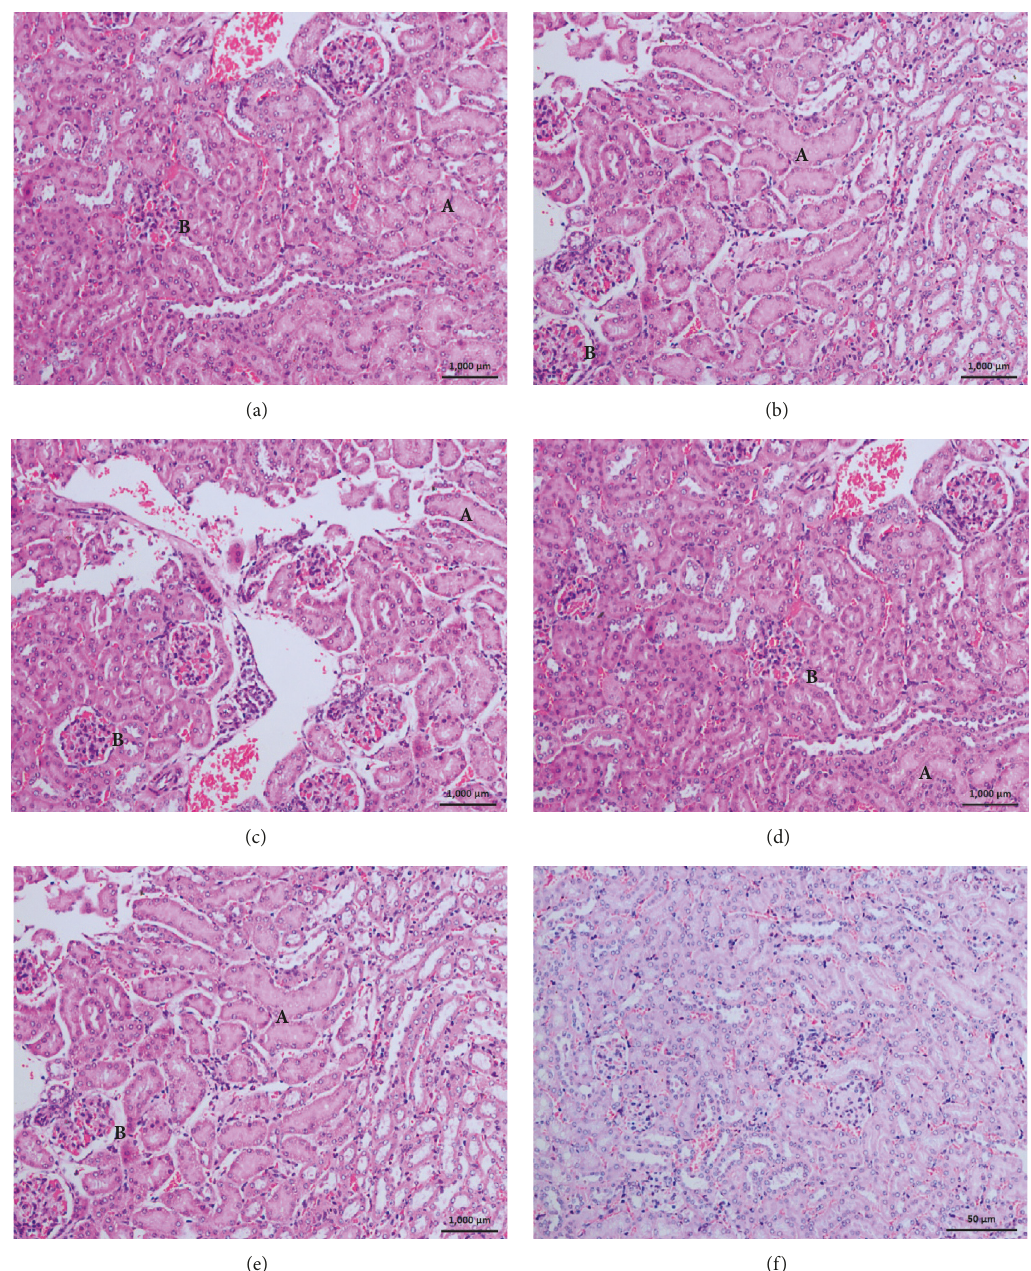
Figure 5: Histopathological changes in kidney, after 3hr from injection of N. naja venom from (a) Western Region Population, (b) Central Region Population, (c) North Region Population, (d) Sabaragamuwa Region Population, (e) Southern Region Population, and (f) Control. (A) Acute tubular necrosis. (B)